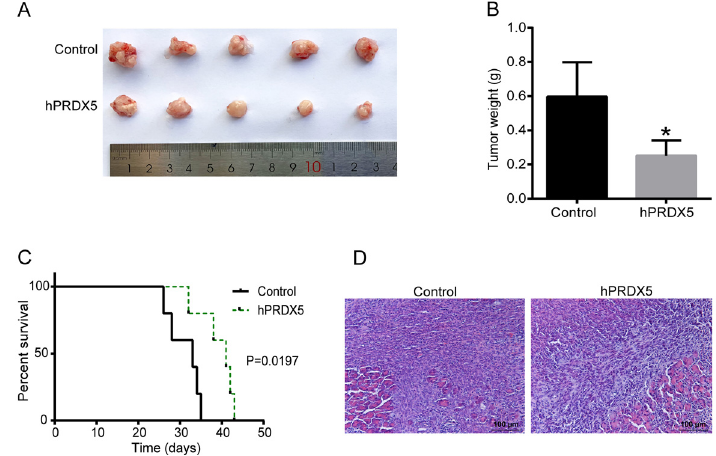
Figure 1. Treatment with human peroxiredoxin-5 (hPRDX5) alone exhibited in vivo antitumor activity in a mouse orthotopic transplantation model. A , Images of tumor tissues from tumor-bearing C57BL/6 mice. The tumors in the hPRDX5-treated group were smaller than those in the control group. B , The tumor weights decreased in hPRDX5-treated mice. C , The survival period was prolonged in hPRDX5-treated mice. D , Representative images of H&E staining of mouse pancreatic tumor (scale bar 100 m m). Data are reported as means ± SD. *P o 0.05 compared with the control ( t